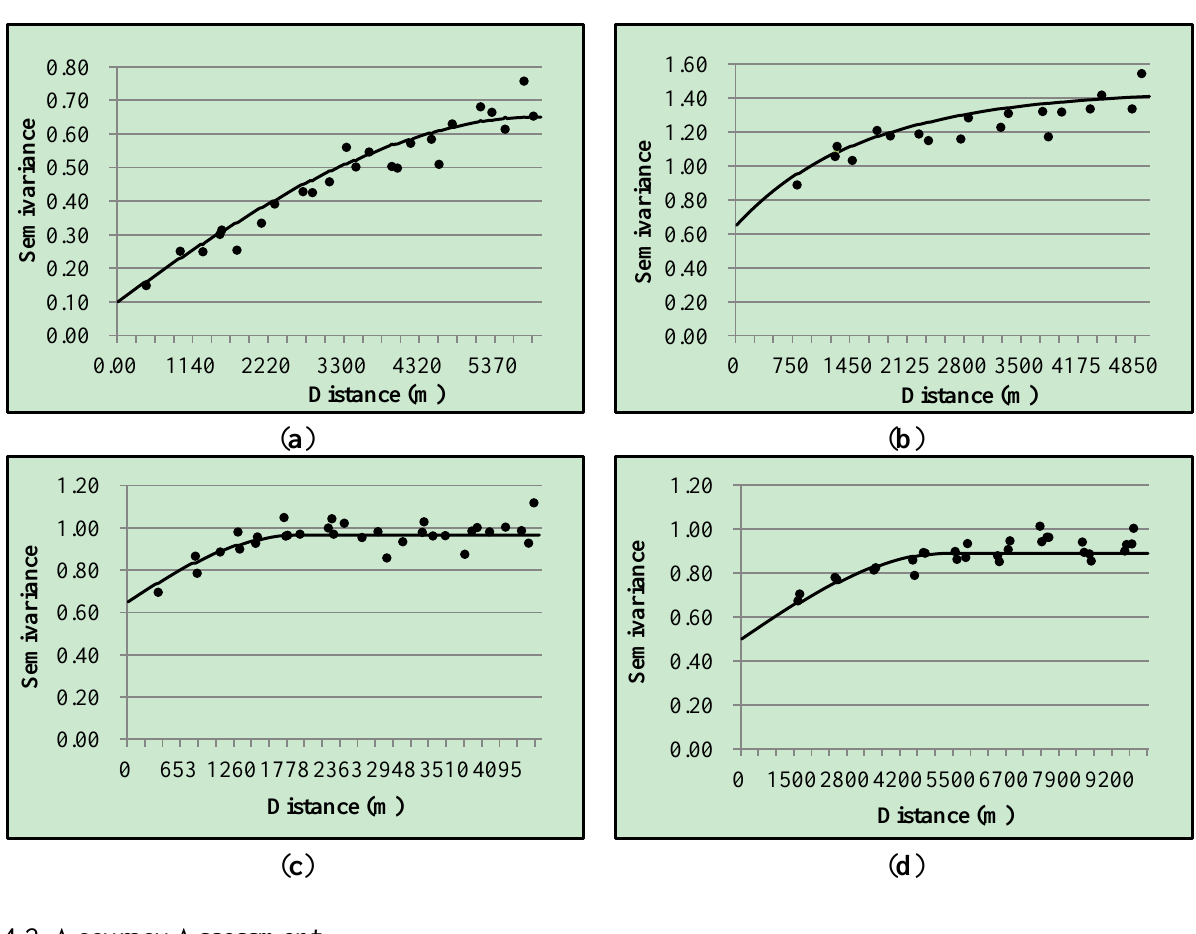
Figure 3. Fitted variogram for each extracted canonical correspondence analysis (CCA) ordination axis in the northern study area. ( a ) Semivariance diagram of CCA scores for axis 1; ( b ) Semivariance diagram of CCA scores for axis 2; ( c ) Semivariance diagram of CCA scores for axis 3; ( d ) Semivariance diagram of CCA scores for axis